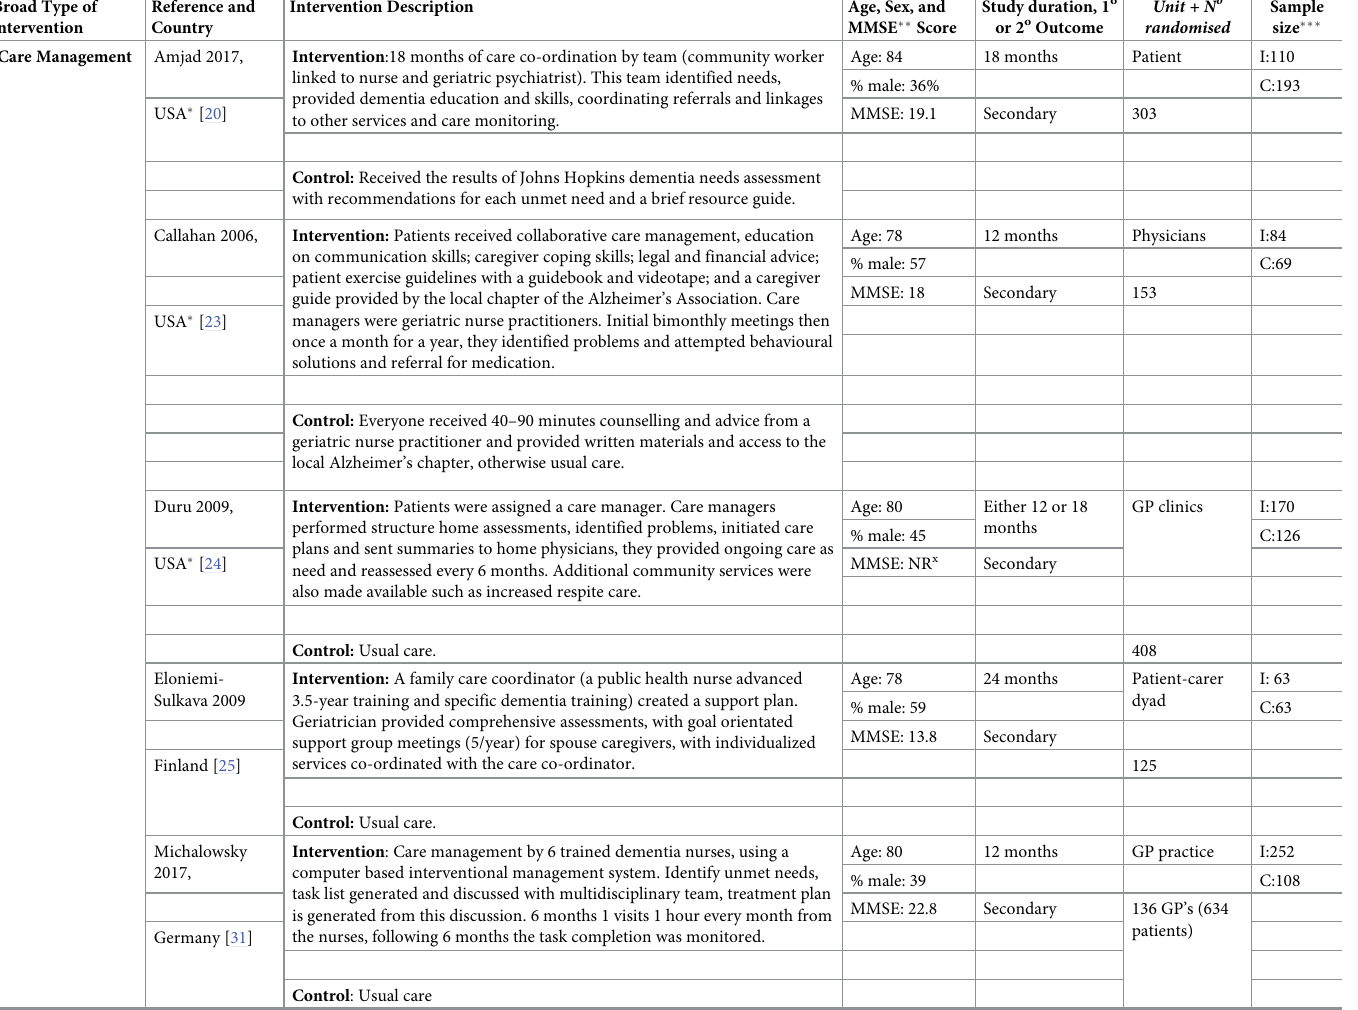
Table 1. Characteristics of included